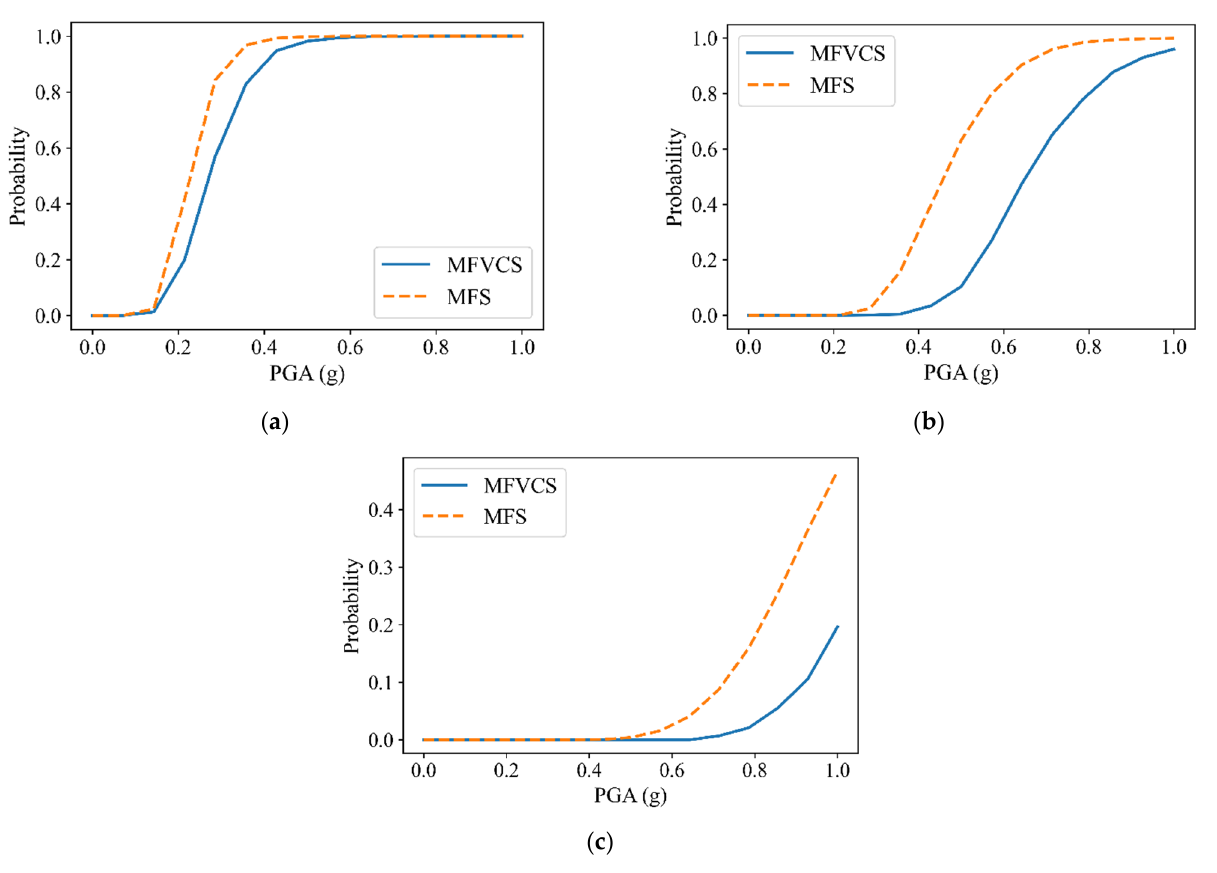
Figure 12. Fragility curves of MFS and MFVCS. ( a ) Immediate occupancy. ( b ) Life safety. ( c ) Collapse prevention.